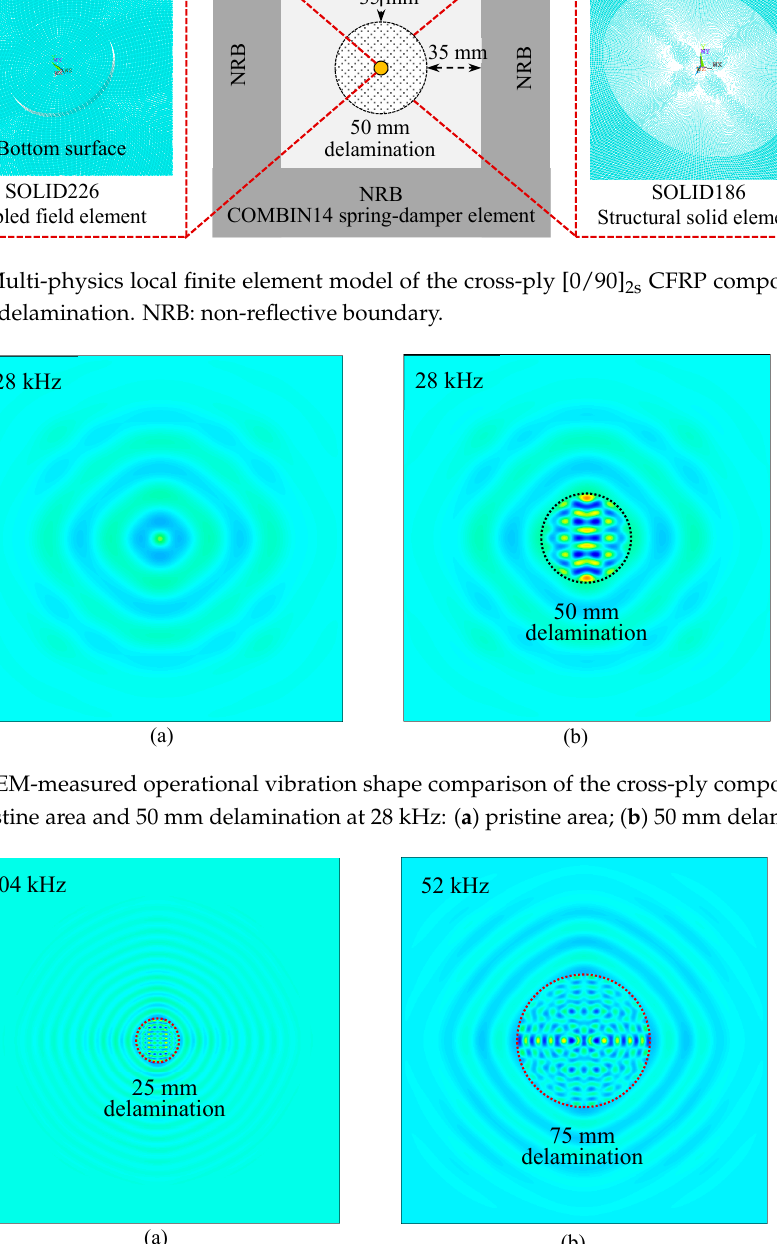
Figure 16. FEM-measured operational vibration shapes of the cross-ply composite plate at the resonance frequencies: ( a ) 25 mm delamination at 204 kHz; ( b ) 75 mm delamination at 52